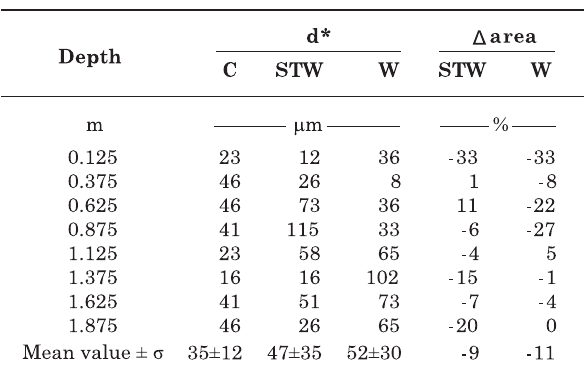
Table 3. Mean pore diameter (d*) for the d θθθθθ /dh maximum curve and difference in the area under the curve when compared with control ( ΔΔΔΔΔ area). C: non-irrigated control plot, STW: wastewater-irrigated plot and W: water- irrigated